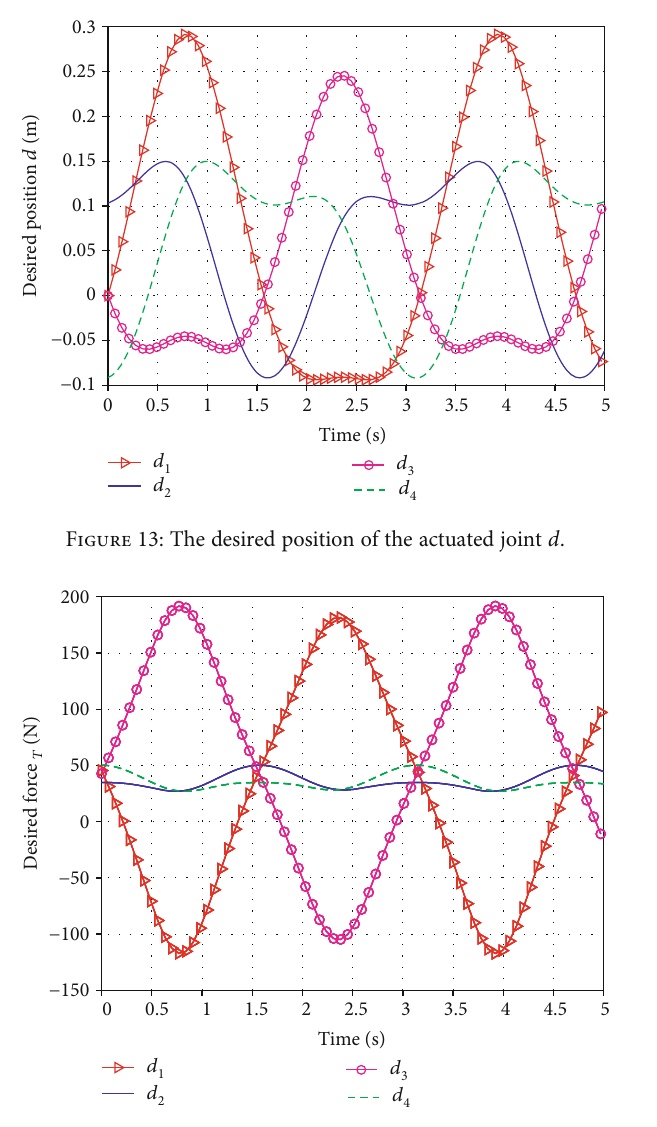
Figure 14: The desired driving force of the actuated joint.